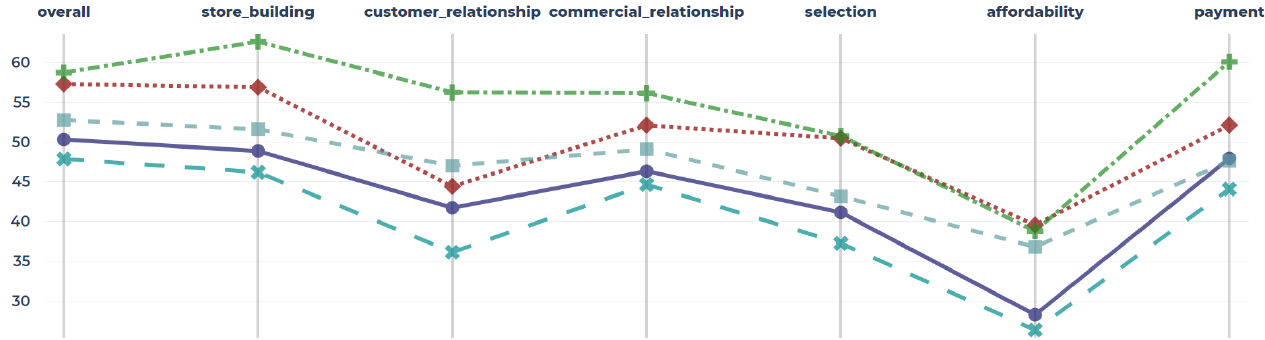
Figure 2. Parallel coordinates plot showing the seven KPIs of five stores (each line represents a